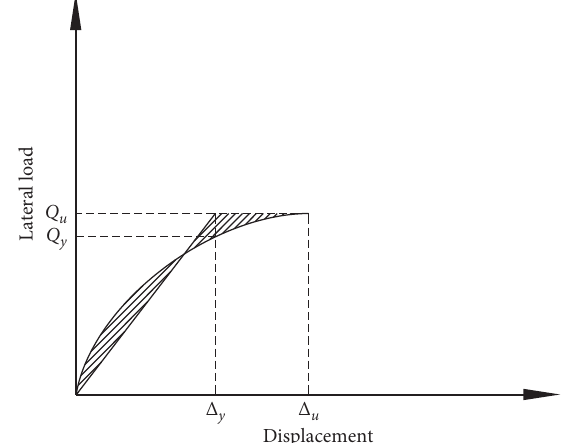
Figure 10: Determination of yielding state.